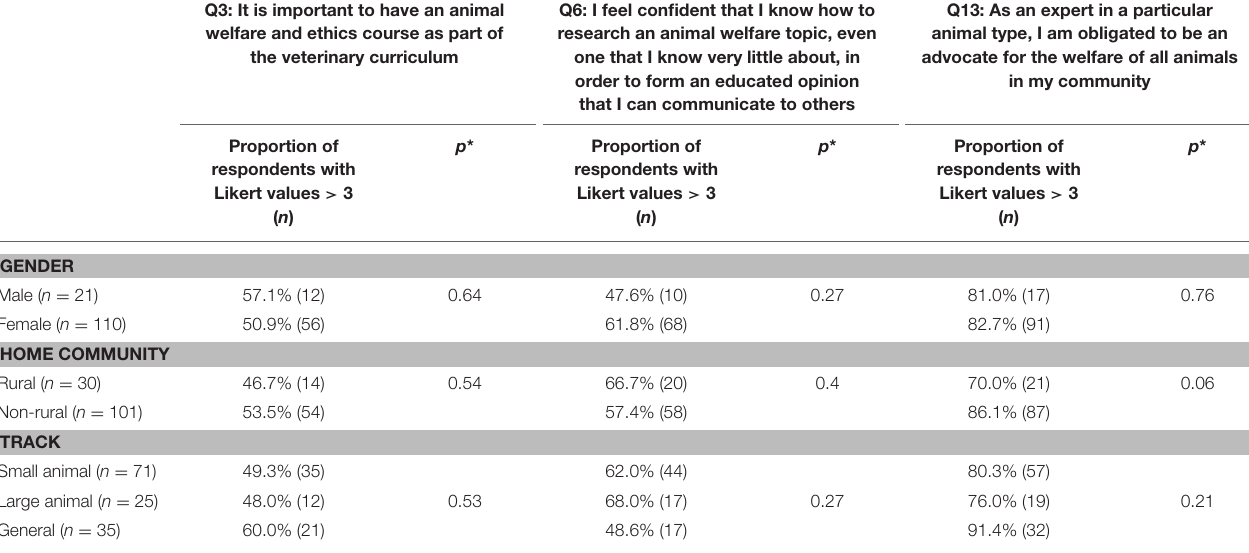
TABLE 5 | Associations of respondent gender, home community, and track selection with pre-course survey responses a to questions containing Likert scale responses. Q3: It is important to have an animal welfare and ethics course as part of the veterinary